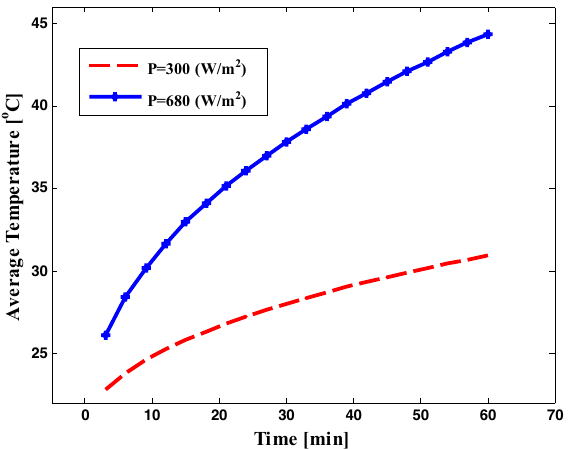
Figure 6. The average temperature versus time of the saline water sample surrounded by an acrylic wall on different heat fluxes as shown.